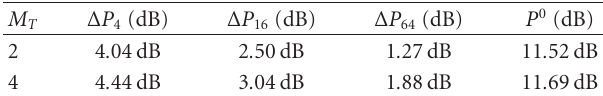
Table 3: PAPR Reduction results for V-BLAST under Di ff erent Number of Antennas and Modulation Types.